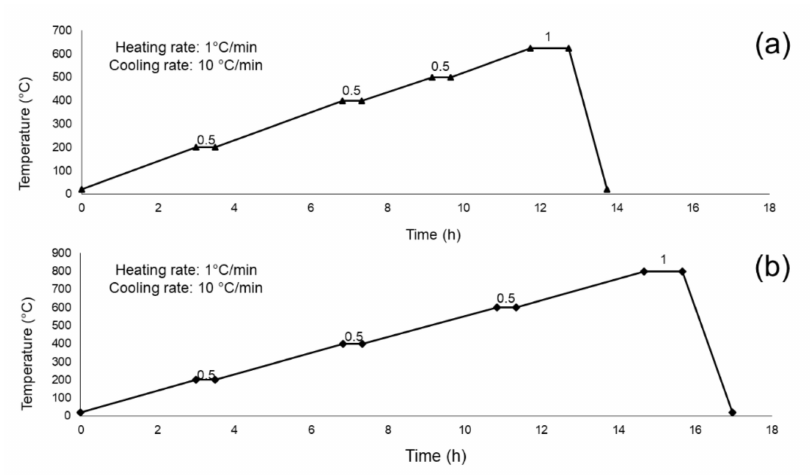
Figure 1. Heating programs used for the calcination of DG-120 at T s1 = 625 ◦ C ( a ) and T s2 = 800 ◦ C ( b ). Intermediate dwelling times and final calcination temperatures were identified on the basis of the di ff erential thermal analysis